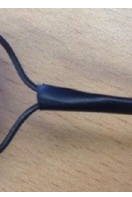
Figure 4. To provide good contact with the electrodes for the measurement of the electromechanical delay, the researcher held a piece of stripboard against the electrodes. A piece of foam was used provide insulation between the researcher’s fingers/thumb and the electrodes. Although this image shows how the stripboard would ideally contact the electrodes, for the assessment of electromechanical delay, the electrodes were embedded in the socket as shown in Fig.